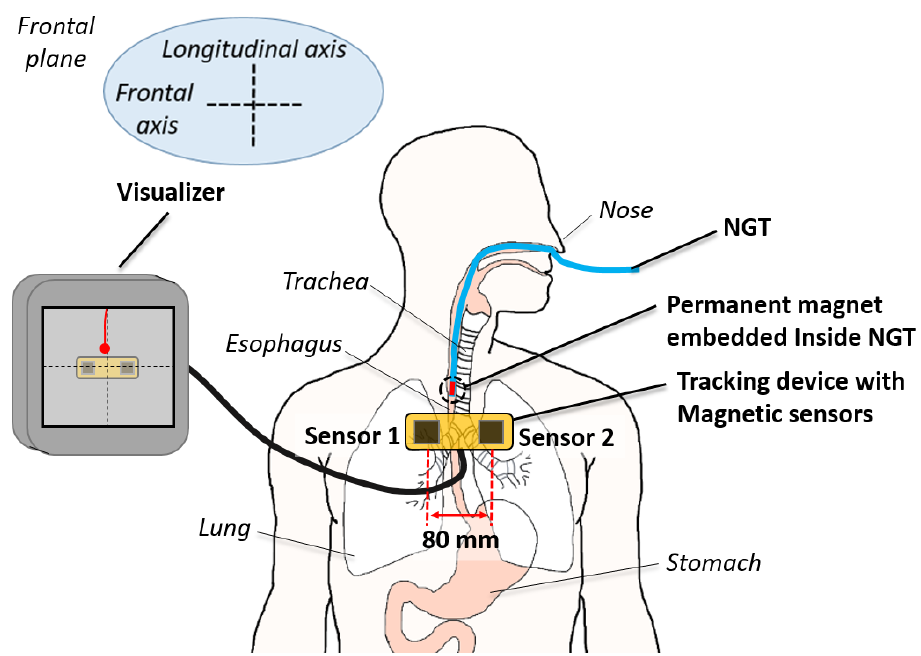
Figure 1. Overview of the two-sensor-based magnetic NGT tracking